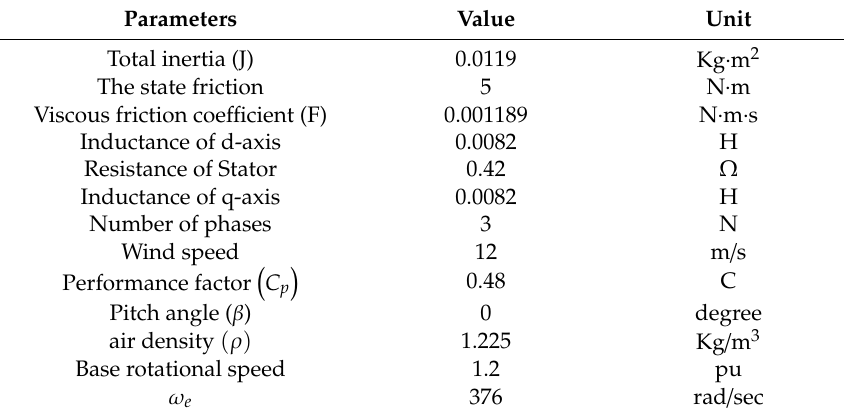
Table 2. Electrical parameters of wind